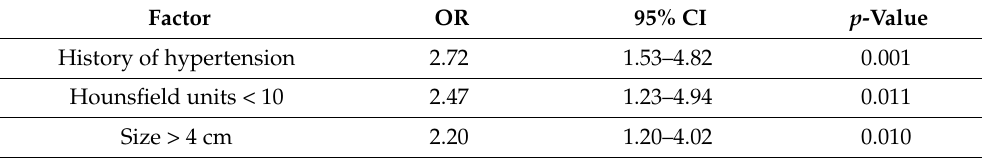
Table 3. Multivariable logistic regression analysis of predictive factors for adrenal